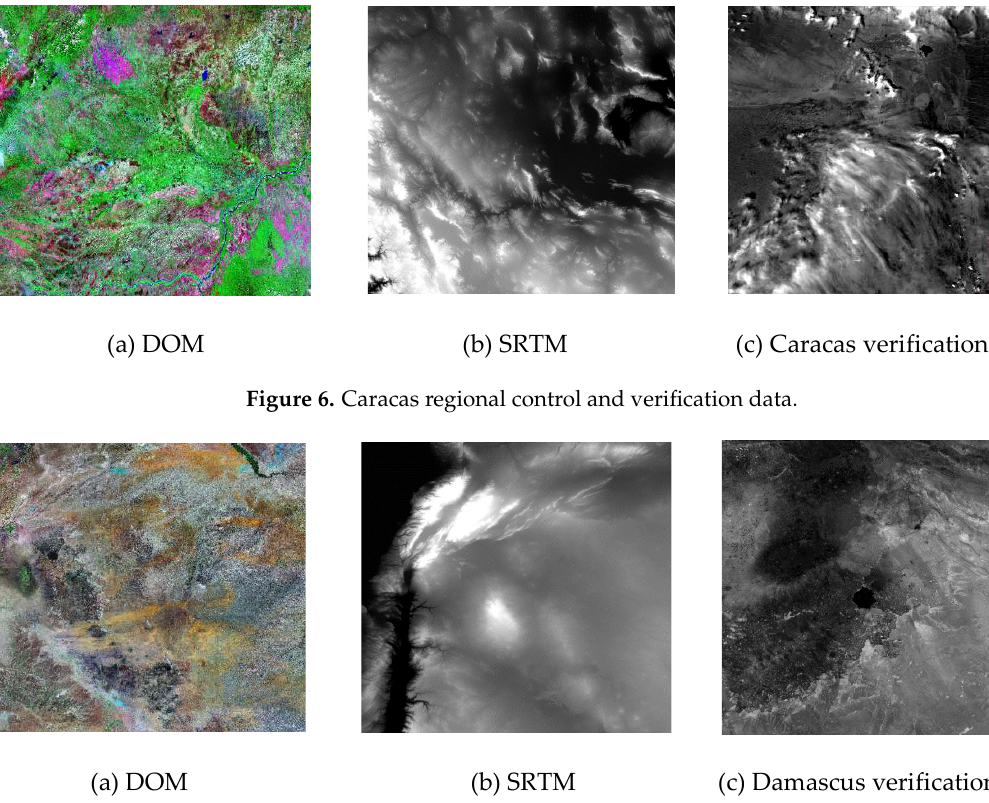
(b) South Korea Figure 8. Thumbnails for relative positioning accuracy verification. Table 3. Imaging information of experimental data. ID